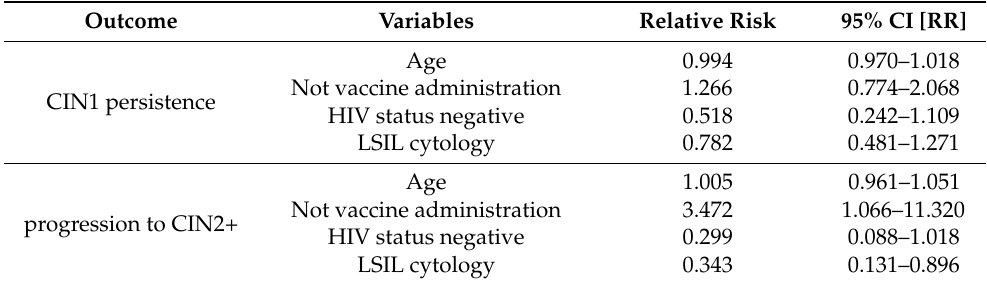
Table 5. Relative risk (RR) after Multivariate analysis of the development of a CIN2+ lesion during